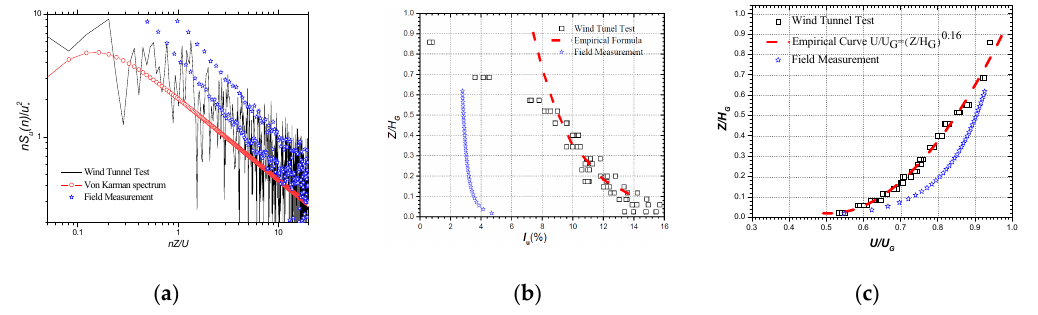
Figure 8. Turbulent flow characteristics for a Type B ABL flow field simulated in a TJ-3 wind tunnel and measured in the field (H G and U G refer to the gradient height (275 m) and the geostrophic velocity (18.95 m/s), respectively). ( a ) Power spectral density of along-wind velocity; ( b ) Turbulence intensity profile, Empirical Formula [29]; ( c ) Mean wind velocity profile.